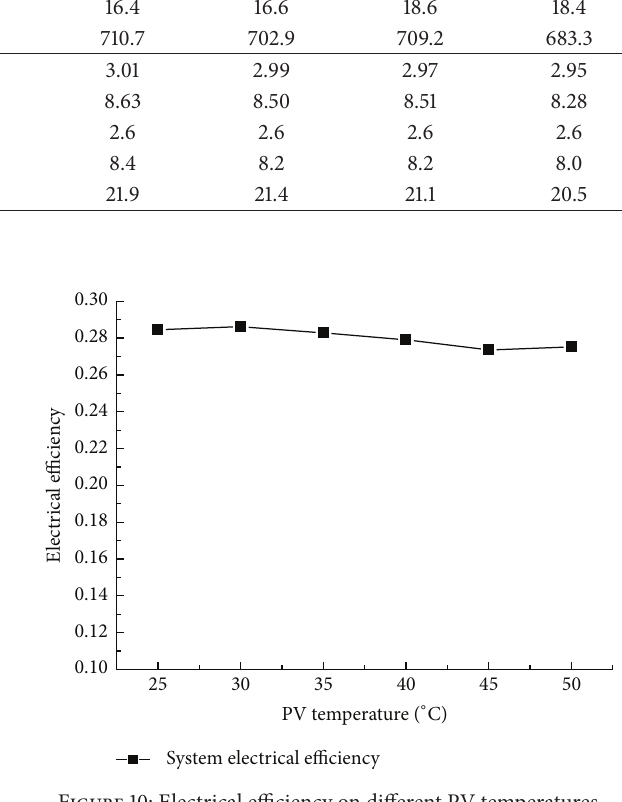
Figure 10: Electrical efficiency on different PV